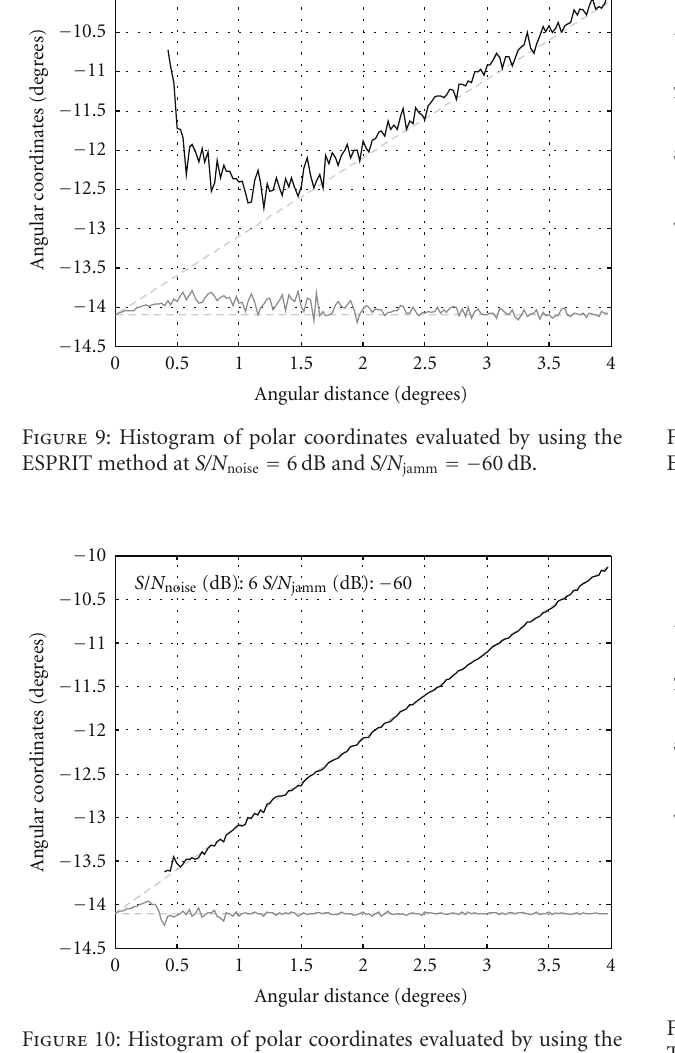
interfering signals are received. The corresponding results of simulations are summarized in Table